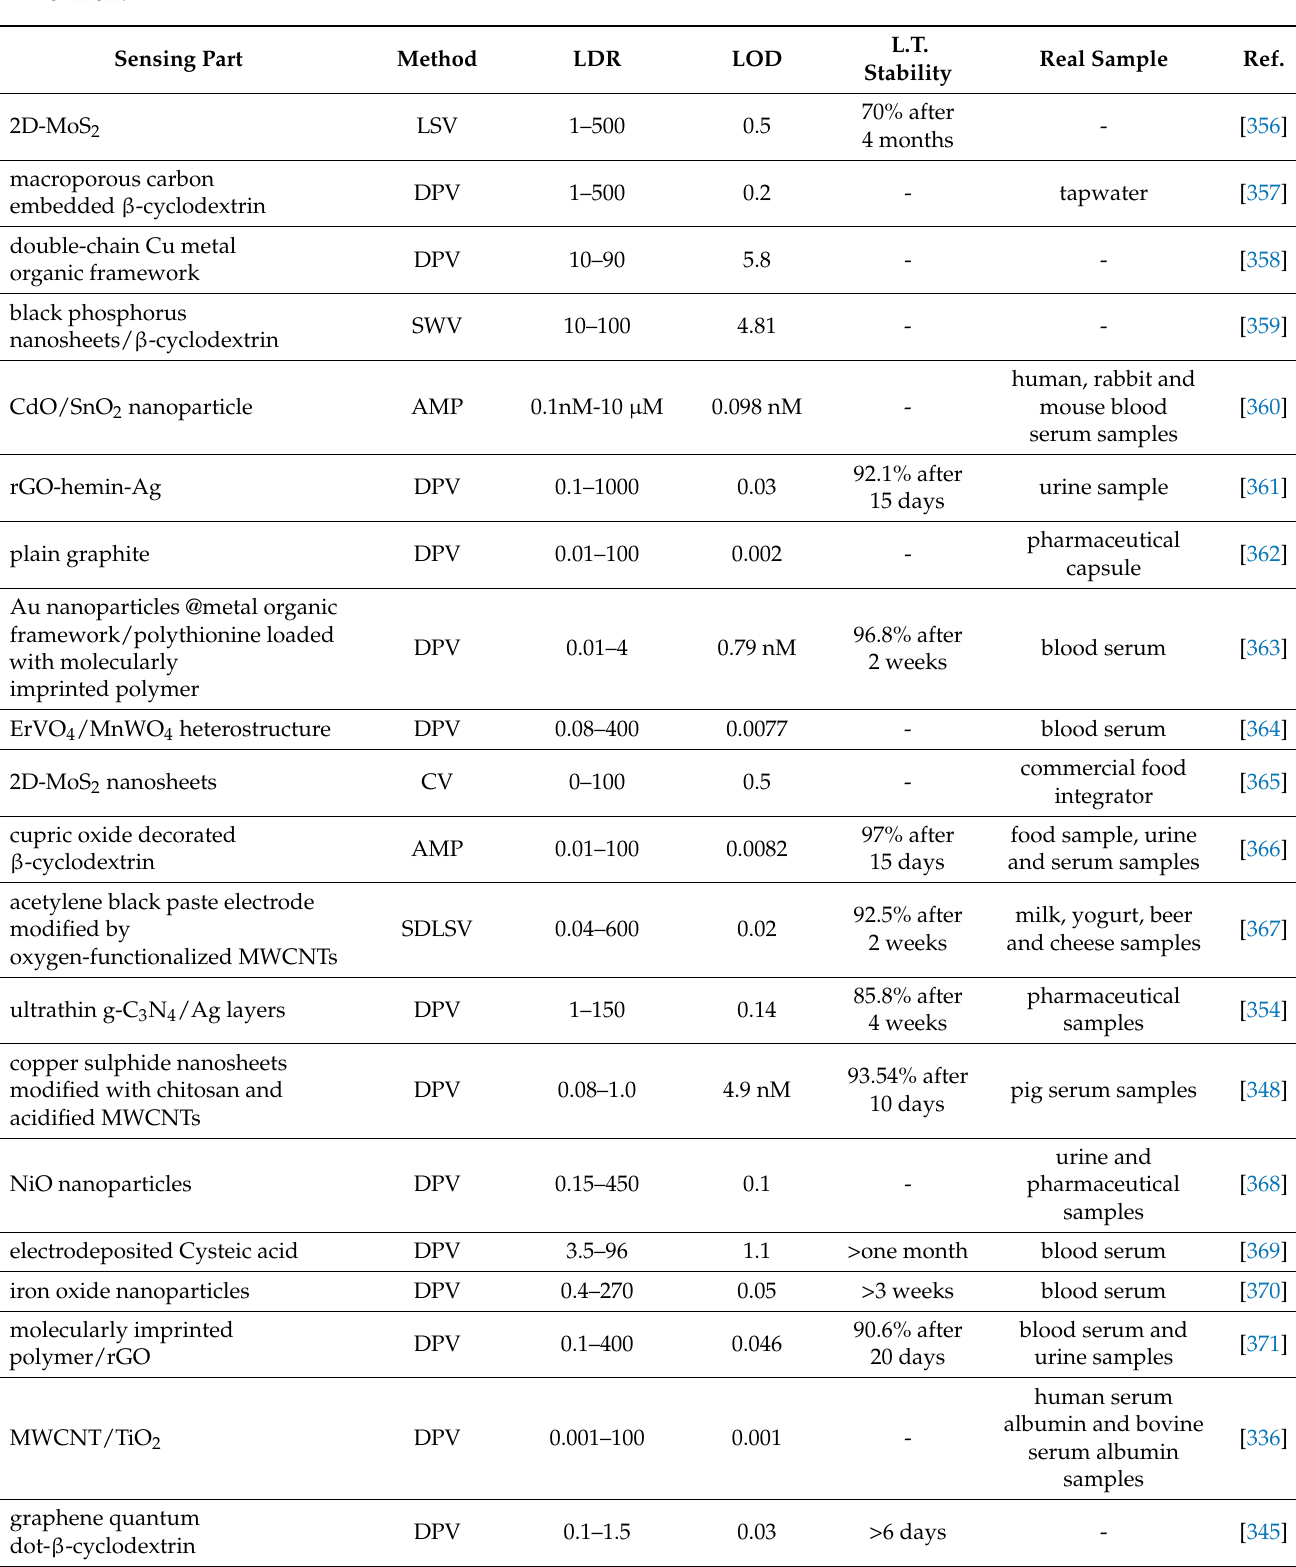
Table 5. Proposed electrochemical tyrosine sensors, since 2010, along with the most important corresponding figures of